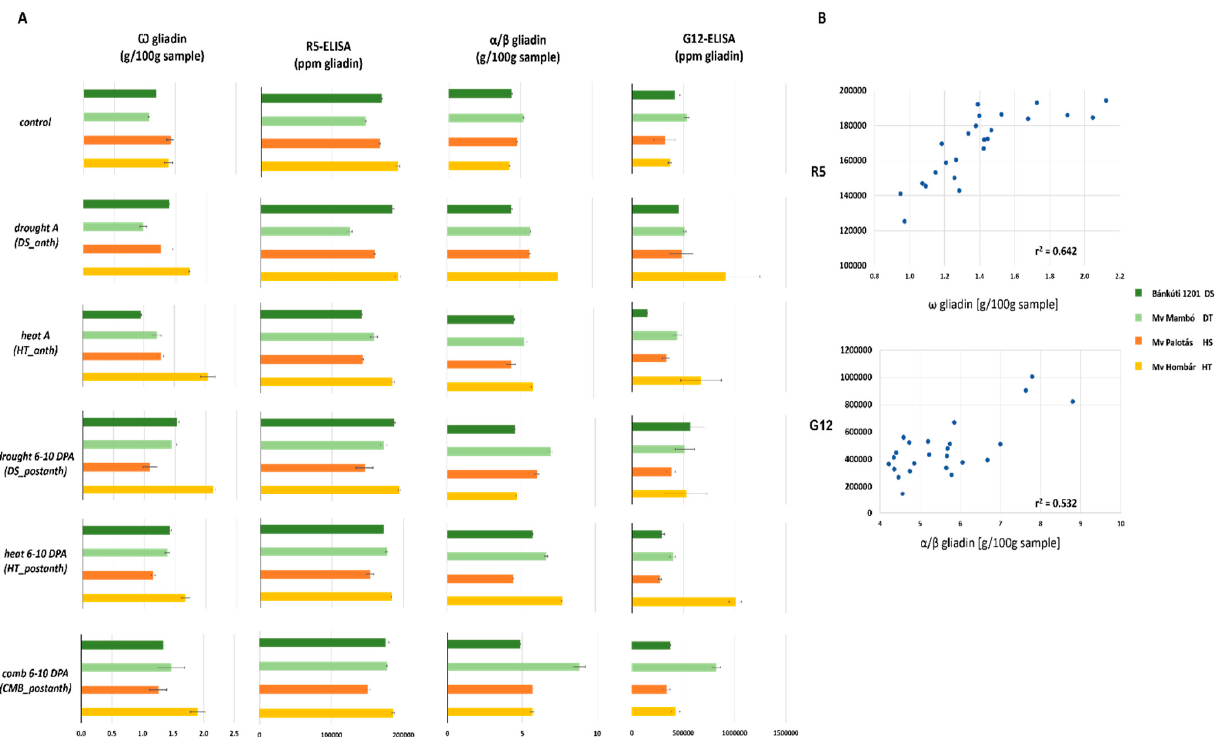
Figure 4. Comparison ( A ) and relationship ( B ) of gliadin levels determined by SE-HPLC as well as R5 and G12 ELISA tests. DS_anth : drought stress at anthesis; HT_anth : high temperature at anthesis; CMB_anth : combined stress at anthesis; DS_postanth : drought stress at post-anthesis; HT_postanth : high temperature at post-anthesis; CMB_postanth : combined stress at